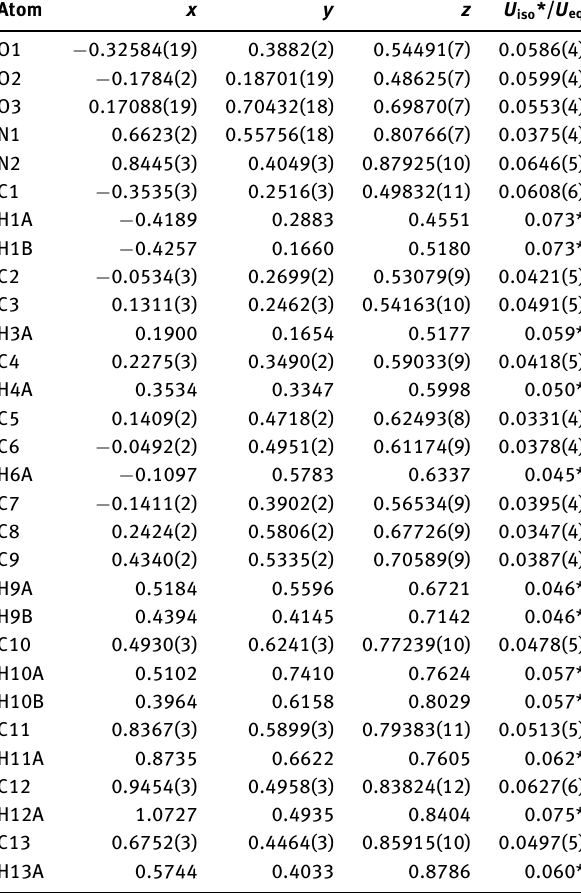
Table 2: Fractional atomic coordinates and isotropic or equivalent isotropic displacement parameters (Å 2